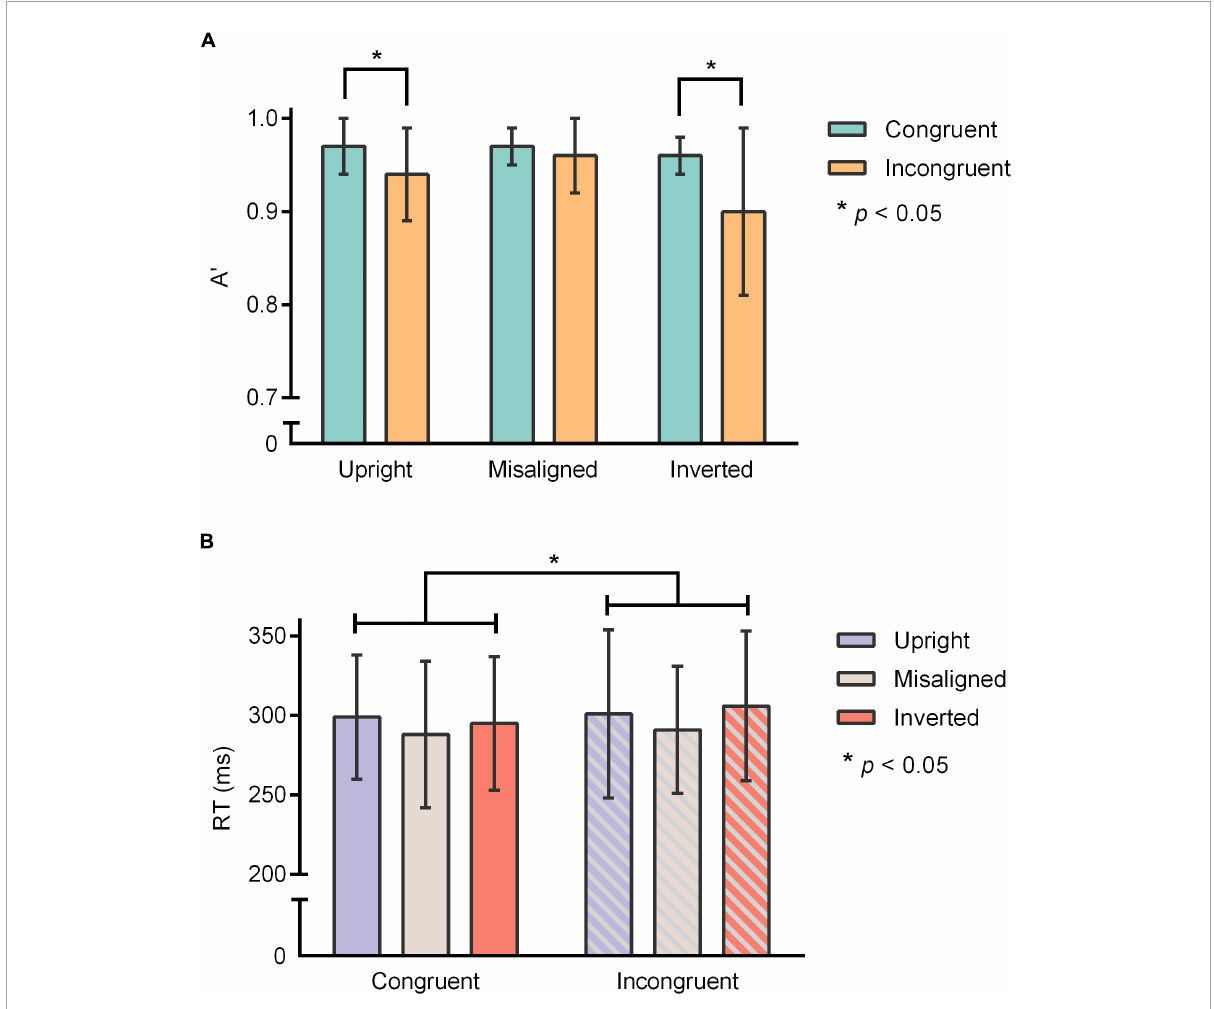
FIGURE2 (A) Discrimination sensitivity (A’) in the composite task for upright, misaligned, and inverted Chinese characters. (B) Response time on congruent trials and incongruent trials. * p < 0.05.